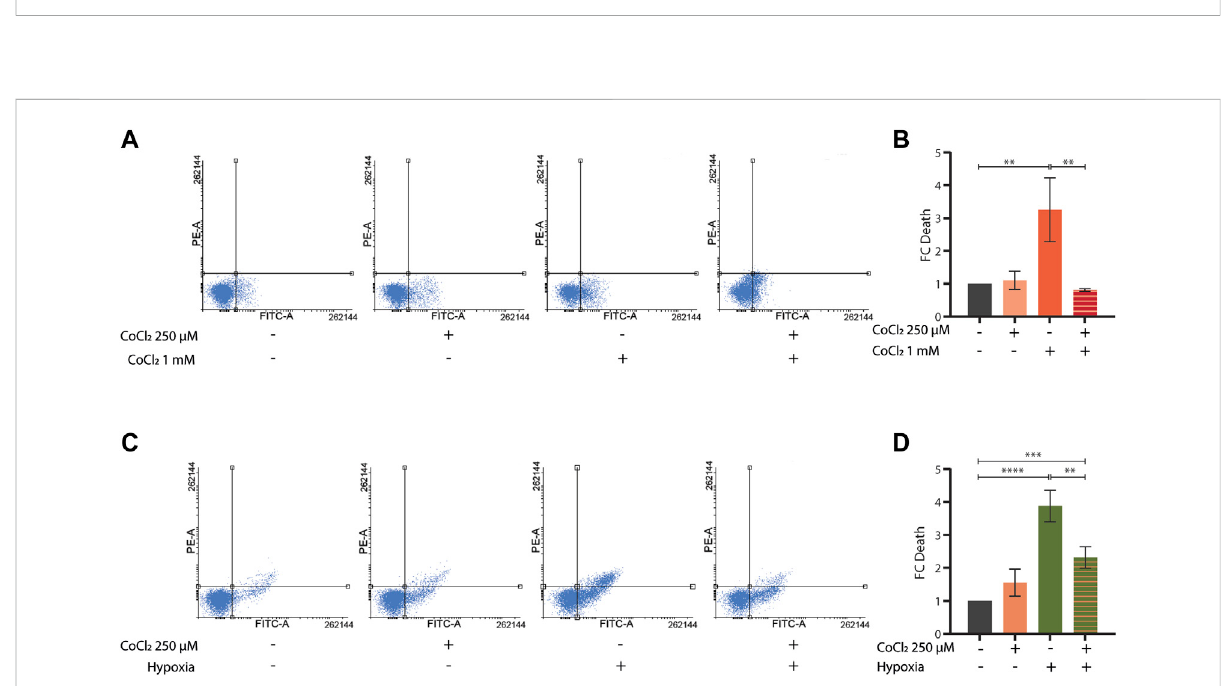
FIGURE 4 (A – D) Representative FACS plot (A,C) and quanti fi cation (B,D) of cell death assays performed in HeLa cells left untreated or treated with CoCl 2 1 mMfor48 h (A,B) orseverehypoxia( < 1%O 2 for48 h) (C,D) aloneorincombinationwitheitheraCoCl 2 250 µMpre-treatmentfor24 hfollowedby 4 h recovery (A,B) or a CoCl 2 250 µM co-treatment for 48 h, respectively. Bar graph represents means ± SD ( n = 3); two-way ANOVA (Tukey ’ s multiple comparison test). ** p value < 0.01 and **** p value <